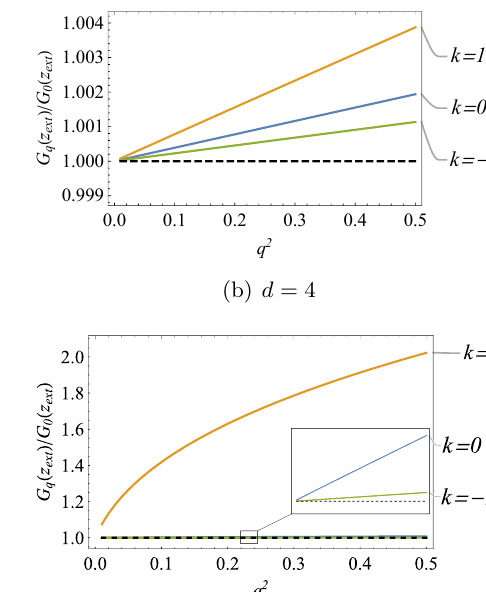
. the vertical axis represents 2 π